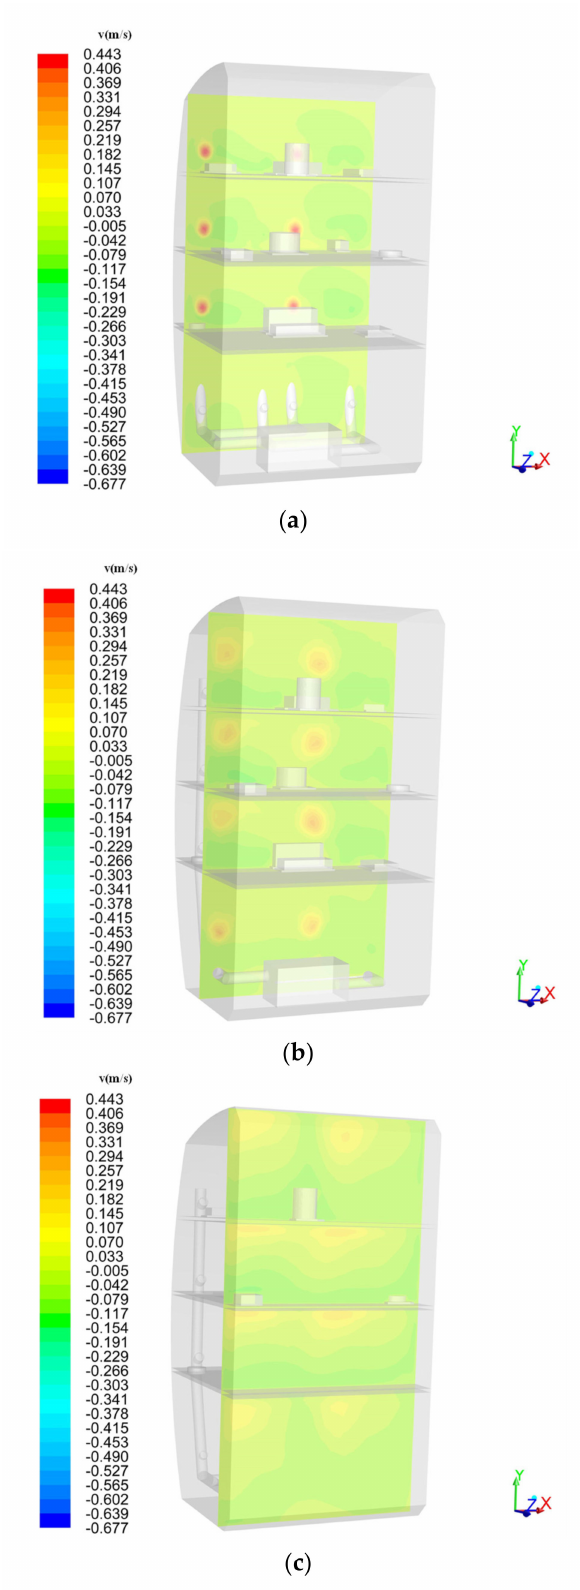
Figure 15. Velocity distribution in z direction of traditional 120 ◦ lower air supply. ( a ) x = 320 mm, ( b ) x = 550 mm, and ( c ) x = 900